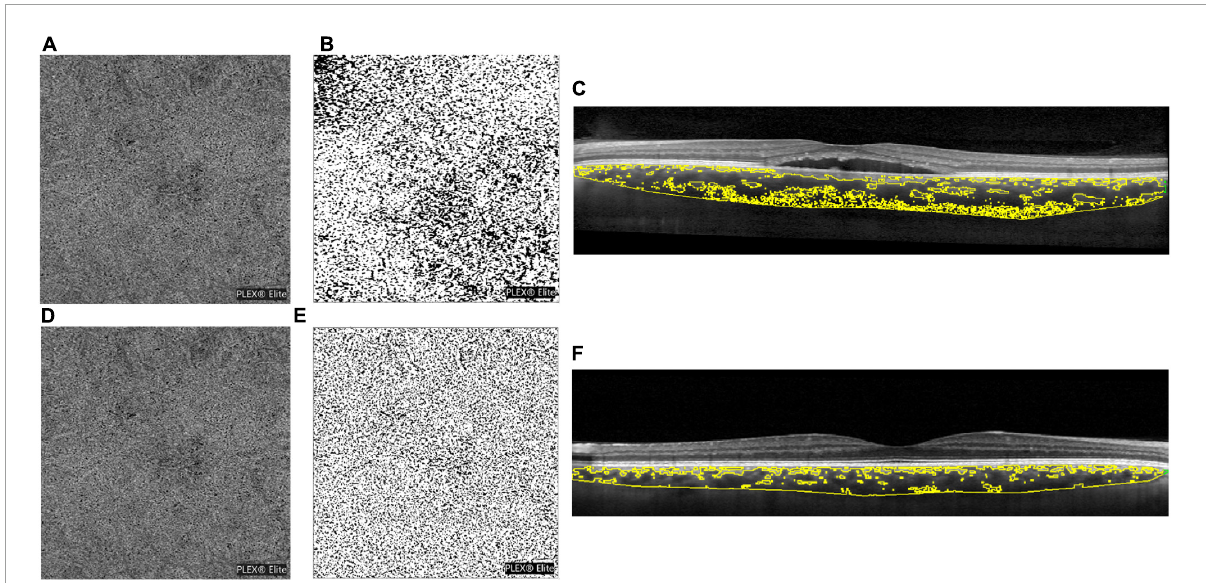
FIGURE1 (A) Optical coherence tomography angiography (OCTA) scan of a central serous chorioretinopathy (CSC) eye after choriocapillaris segmentation and exportation from the PLEX Elite 900 device, showing a hyporeflective flow signal void area. (B) The choriocapillaris images binarized with the Phansalkar method for the quantification of flow signal voids by using ImageJ (public domain software). (C) Enhanced depth optical coherence tomography images highlighting the choroidal vascularity index (CVI). Image binarization was performed with the Niblack autolocal threshold with ImageJ (public domain software) to calculate the total, luminal, and stromal choroidal areas [total choroidal area (TCA), luminal choroidal area (LCA), and stromal choroidal areas (SCA)], and the CVI was calculated as the ratio between LCA and TCA. (D–F) Images in the healthy